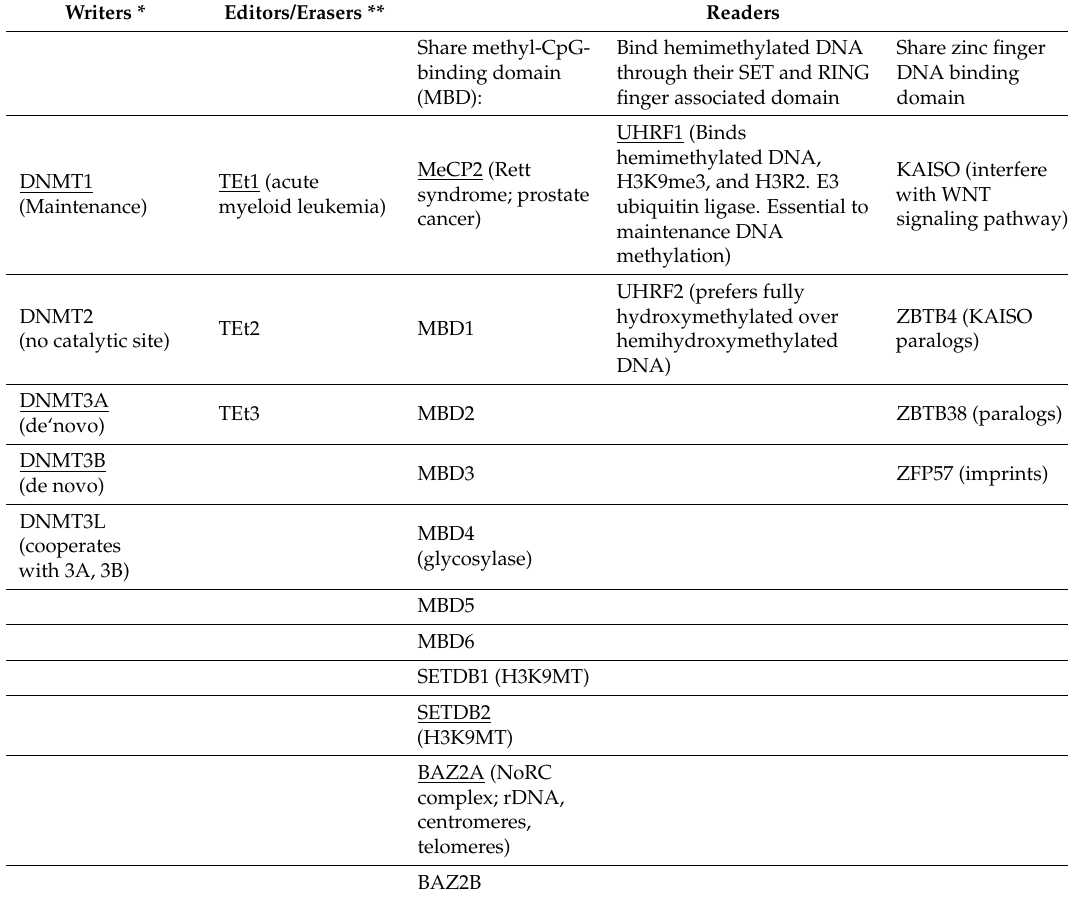
Table 3. Brief annotated list of “writers”, “editors”, “readers” of the DNA methylation